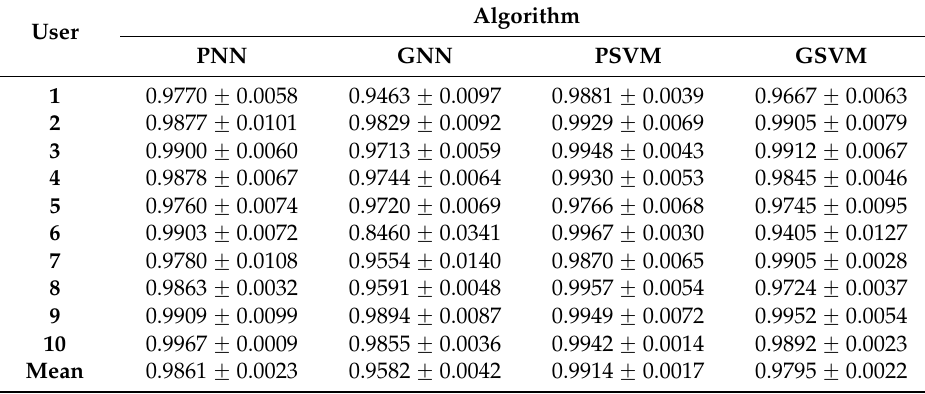
Table 3. AUC values (mean and standard deviation) for the algorithm variants: Personalized NN (PNN), generic NN (GNN), personalized SVM (PSVM) and generic SVM (GSVM). The last row is the average over